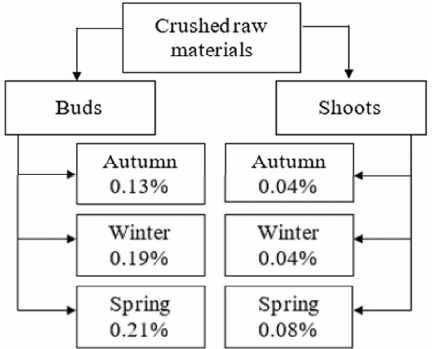
Fig. 2. Comparative characteristics of the yield of essential oils of birch buds and shoots, depending on the time of collection of raw